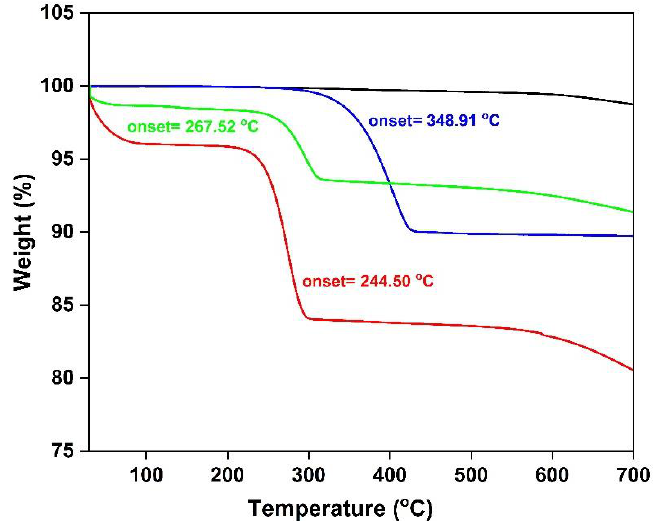
Figure 8. TG results for CF (black), CF-1Cl (red), CF-1NTf 2 (blue) and CF-1OH (green).